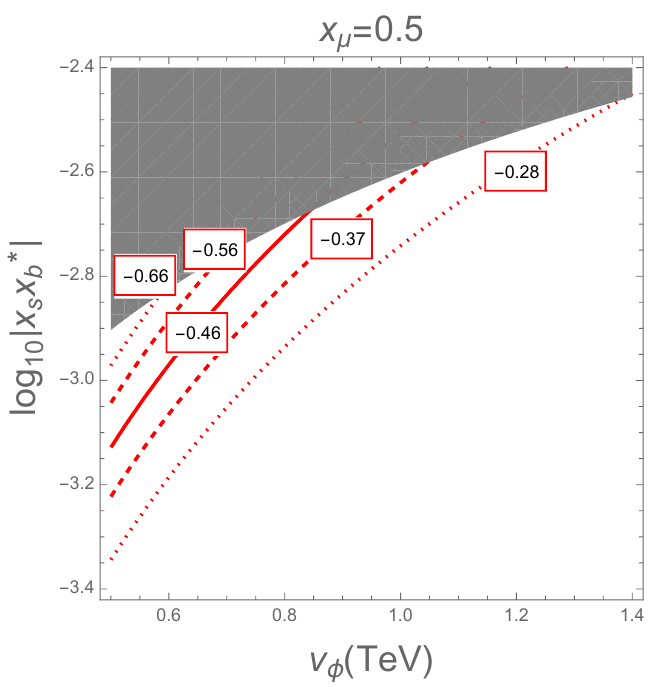
Figure 3 . The solid red line is the central value (1.4) to solve the b → sµ + µ − puzzle. The dashed (dotted) line represents 1 σ (2 σ ) region. The gray region is disfavoured by the B s − B s mixing. We fixed x µ = 0 . 5